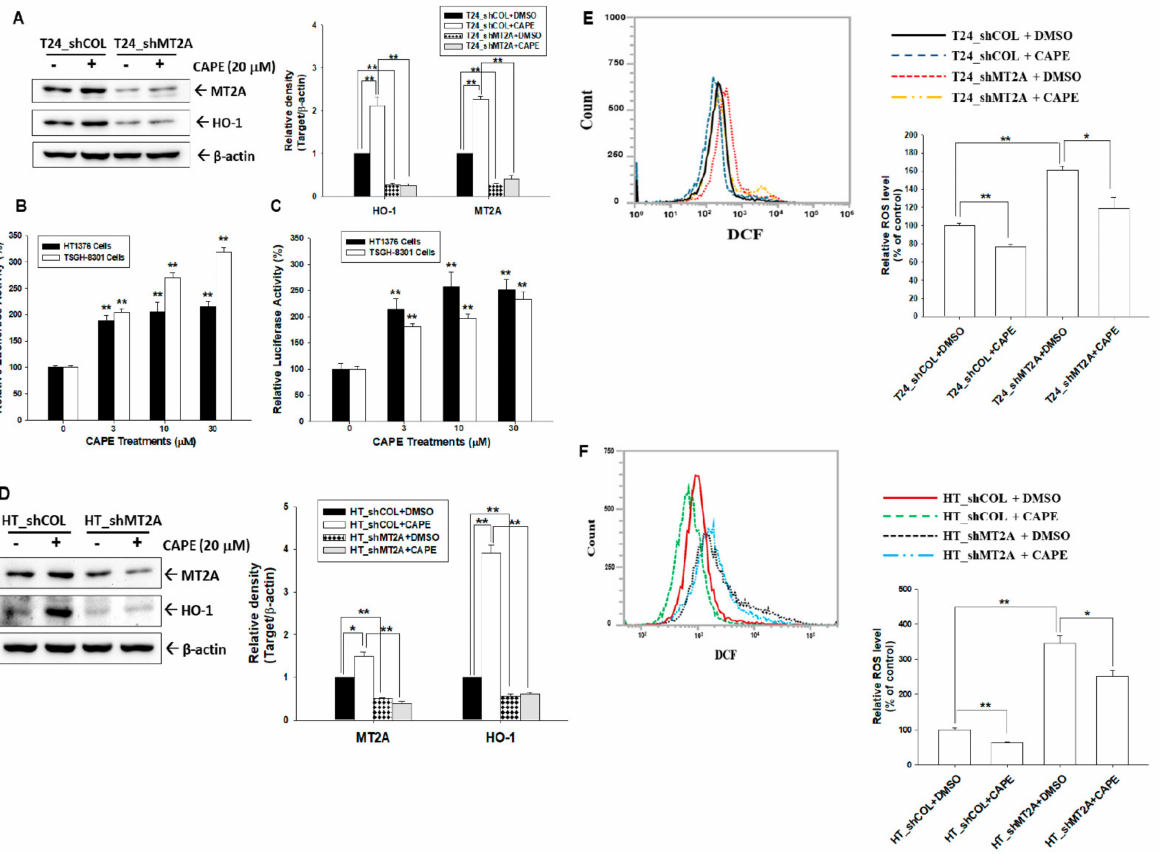
Figure 5. Caffeic acid phenethyl ester induces MT2A and HO-1 expressions to downregulate endoge- nous ROS in bladder carcinoma cells. ( A ) Protein levels of MT2A and HO-1 after CAPE treatments in T24_shCOL and T24_shMT2A cells were determined by immunoblot assays (left). The presented quantitative data were the intensity of the protein bands of the target proteins/ β -actin relative to the mock-knockdown cells (right). The relative luciferase activity of HT1376 (black bars) and TSGH- 8301 (white bars) cells were transfected with the human MT2A ( B ) or HO-1 ( C ) reporter vectors and treated with various concentrations of CAPE. Presented data were the mean percentage ( ± SE, n = 6) compared with the vehicle-treated cells. ( D ) Protein levels of MT2A and HO-1 after CAPE treatments in HT_shCOL and HT_shMT2A cells were examined by immunoblot assays (left). The quantitative values presented were the intensity of the protein bands of the target proteins/ β -actin relative to the mock-overexpressed cells (right). ( E ) Endogenous ROS levels (left) and quantitative data (right) of T24_shCOL and T24_shMT2A after treatment with or without CAPE were determined by flow cytometry. ( F ) Endogenous ROS levels (left) and quantitative data (right) of HT_shCOL and HOT_shMT2A cells after treatment with or without CAPE were measured by flow cytometry. * p < 0.05; ** p <